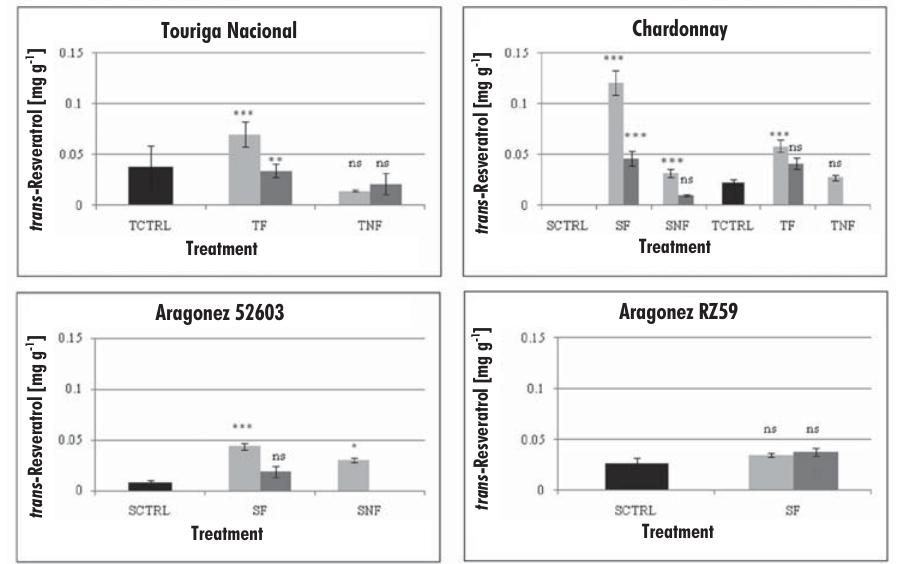
Fig. 3. trans -Resveratrol content in healthy and infected plants, from cv. Touriga Nacional, cv. Chardonnay, cv. Aragonez (52603) and cv. Aragonez (RZ59). Different tissue types are represented with infected plants: colonised trunk tissue (TF), uncolonised trunk tissue (TNF), colonised shoot tissue (SF) and uncolonised shoot tissue (SNF). Error bars represent standard deviation (n=4). Level of statistical signi fi cance is also indicated as *, P <0.05; **( P <0.01); ***, P <0.001; ns, non- signi fi cant. Control ( ¢ ), PH9 ( ¢ ), PH13 ( ¢ ). For control treatments, TCTRL refers to trunk control and SCTRL refers to shoot control.